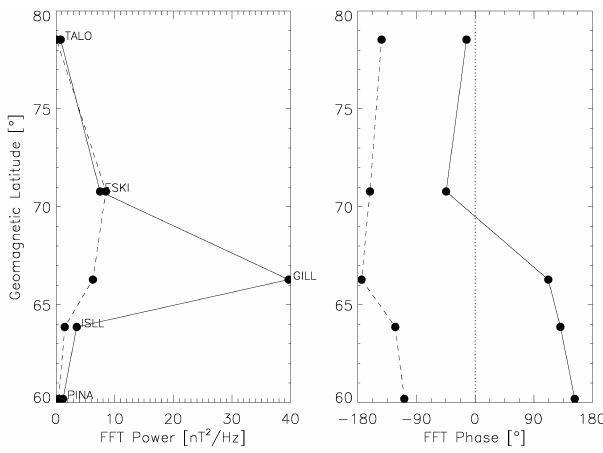
Fig. 4. Latitude profile of Fourier power and phase at 3.1mHz on 24 October 2004. The profile of the North-South component is shown as solid lines, the dashed lines give the profiles for the East-West component.